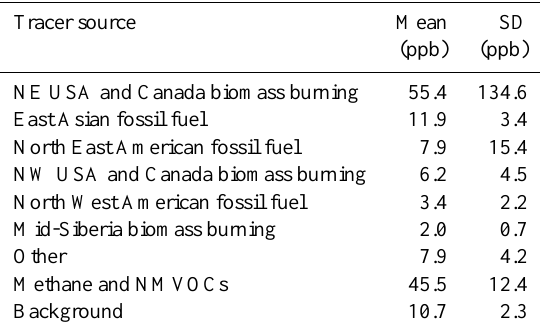
Table 1. Contribution of CO from geographical sources averaged over all BORTAS-B flights, lumping all other contributions < 2ppb into “Other”. “Background” refers to any residual CO before the beginning of the BORTAS-B